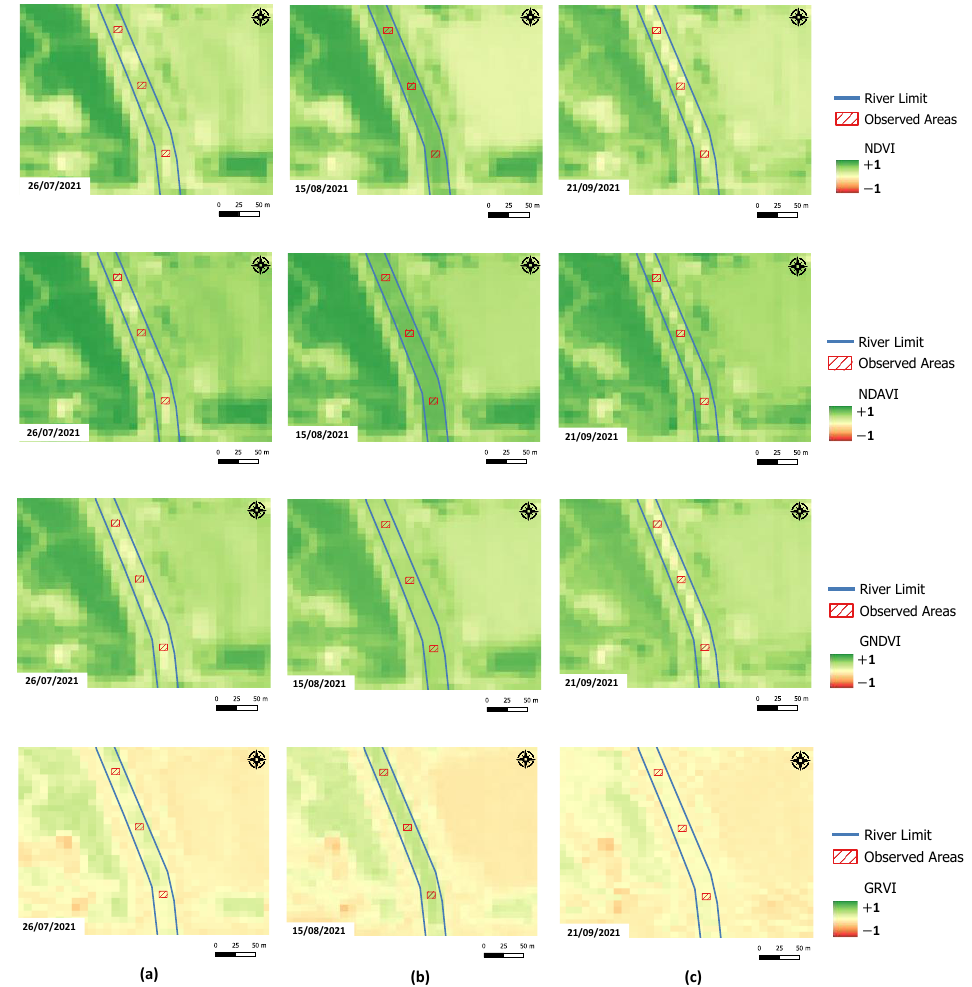
Figure 5. Maps illustrating the spatial distribution of the presence of invasive aquatic plants ( Lemna minor ) in a section of the Lis River (Figures 1–3), for VIs NDVI, NDAVI, GNDVI, and GRVI. The data are from Sentinel-2 imagery (10 m spatial resolution), for 2021: ( a ) 26 July; ( b ) 15 August; ( c ) 21 September. The maps apply a red-yellow-green palette to the VIs’ imagery: green signals healthy vegetation and red signals areas lacking vegetation.